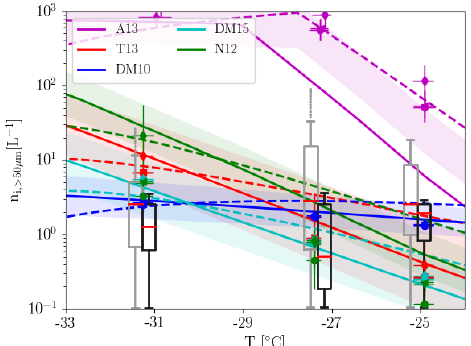
Figure 6. Temperature dependency of ice crystal number concen- tration against air temperature from observations (2DC, boxplots) and UM model simulations (symbols; colours represent simula- tions with different ice nucleation schemes according to legend in Fig. 4a). Model data are interpolated to the hypothetical flight tracks and only considered in the first part of each flight leg, i.e. the up- draught region. Observational data are also subsampled to include only data from the updraught region, which are shown in the black boxplots (grey boxplots show all data). The solid lines show the expected ice crystal number concentration based on ice nucleation only using the prescribed dust profiles. The colour shading illus- trates the expected ice crystal number concentration for dust number concentrations within a factor of 2 of the used profile, i.e. compat- ible with range observed upstream of the cloud. Assuming a linear decrease in the upstream dust concentration over the time period of the observations together with the assenting flight pattern results in expected ice crystal number concentration as shown by the dashed